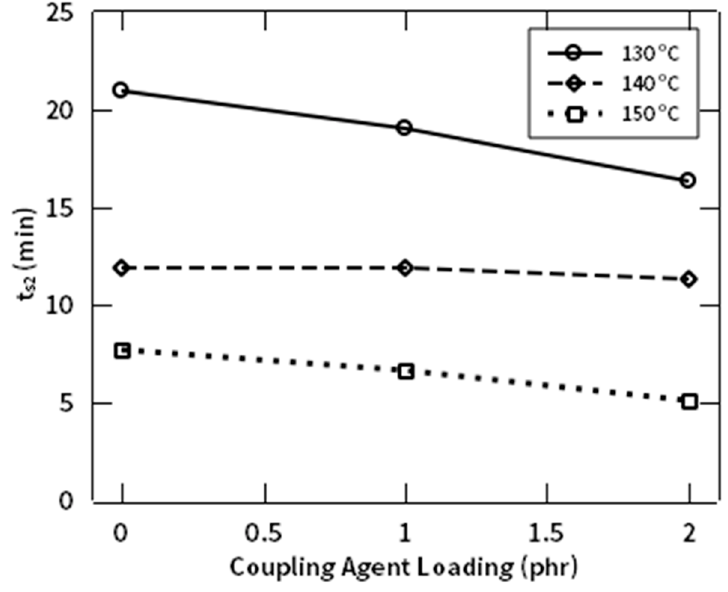
Figure 11. ts 2 profile of NR compound at different composition of NR-g-St.